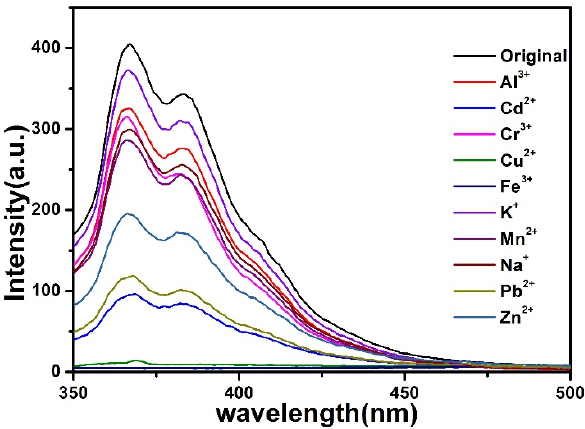
Figure 5. Fluorescence spectra of the compound towards different metal ions.